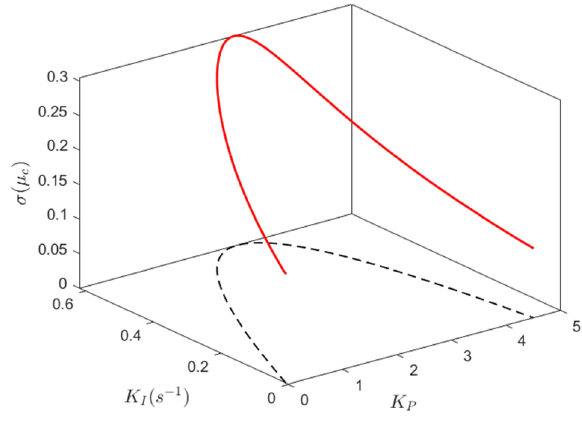
(cid:48) ( µ σ μ′ corresponding to the bifurcation line. σ μ′ corresponding to the bifurcation line. Figure 5. Values of σ c ) corresponding to the bifurcation c c